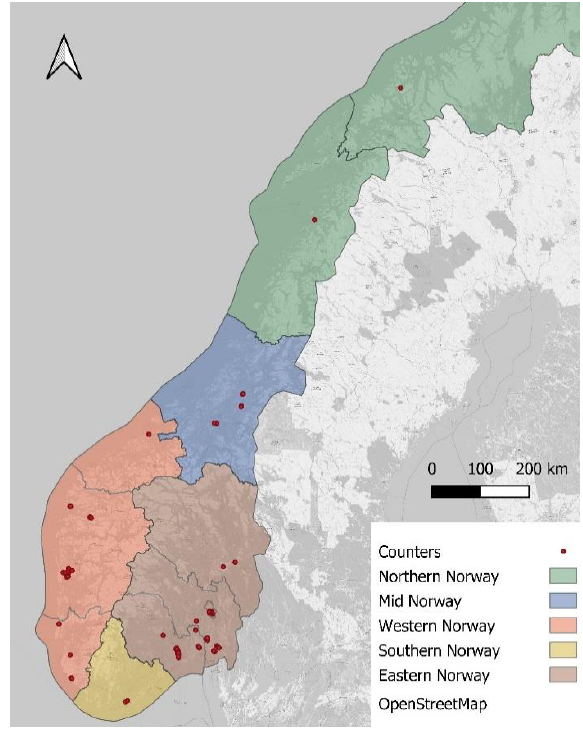
Figure 1. Location of included counters and regional areas. Table 1. Number of counters and population density at the local and regional level.